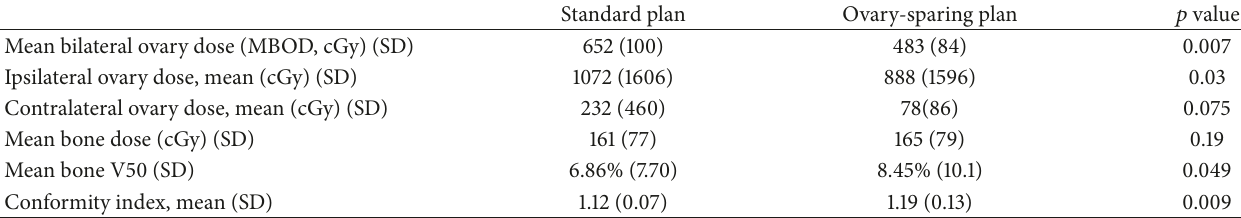
Table 2: Dosimetric comparisons of standard plans and ovary-sparing plans ( 𝑛 = 23 ). Standard plan Ovary-sparing plan 𝑝 value